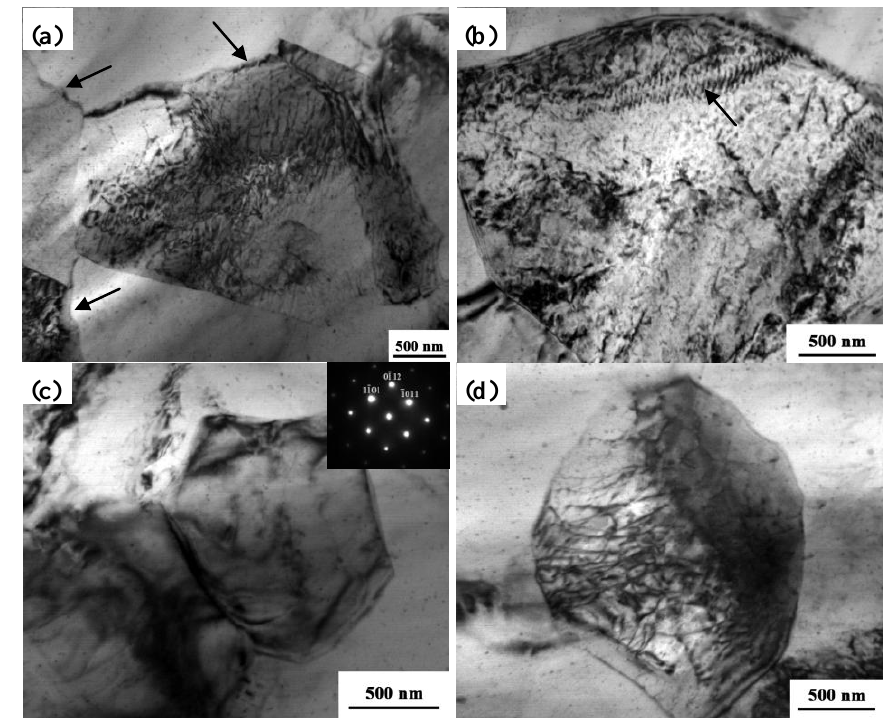
Figure 6. Typical TEM micrographs of the FSP AZ31 specimen: ( a ) and ( b ) NFSP; ( c ) and ( d )